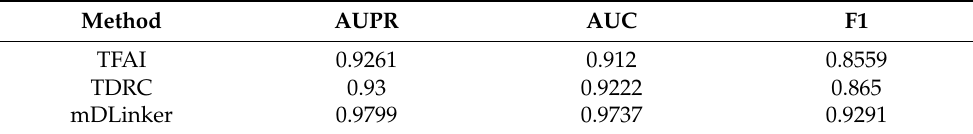
Table 3. Performance comparison among TFAI, TDRC and mDLinker under the setting